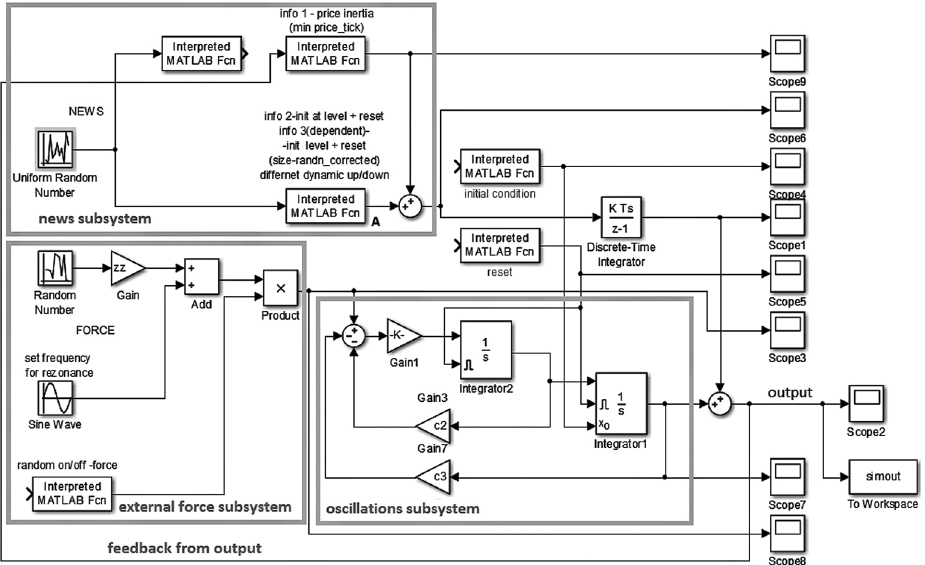
Fig. 20. The entire system, input: economic news, order activities, feedback, skewed, news